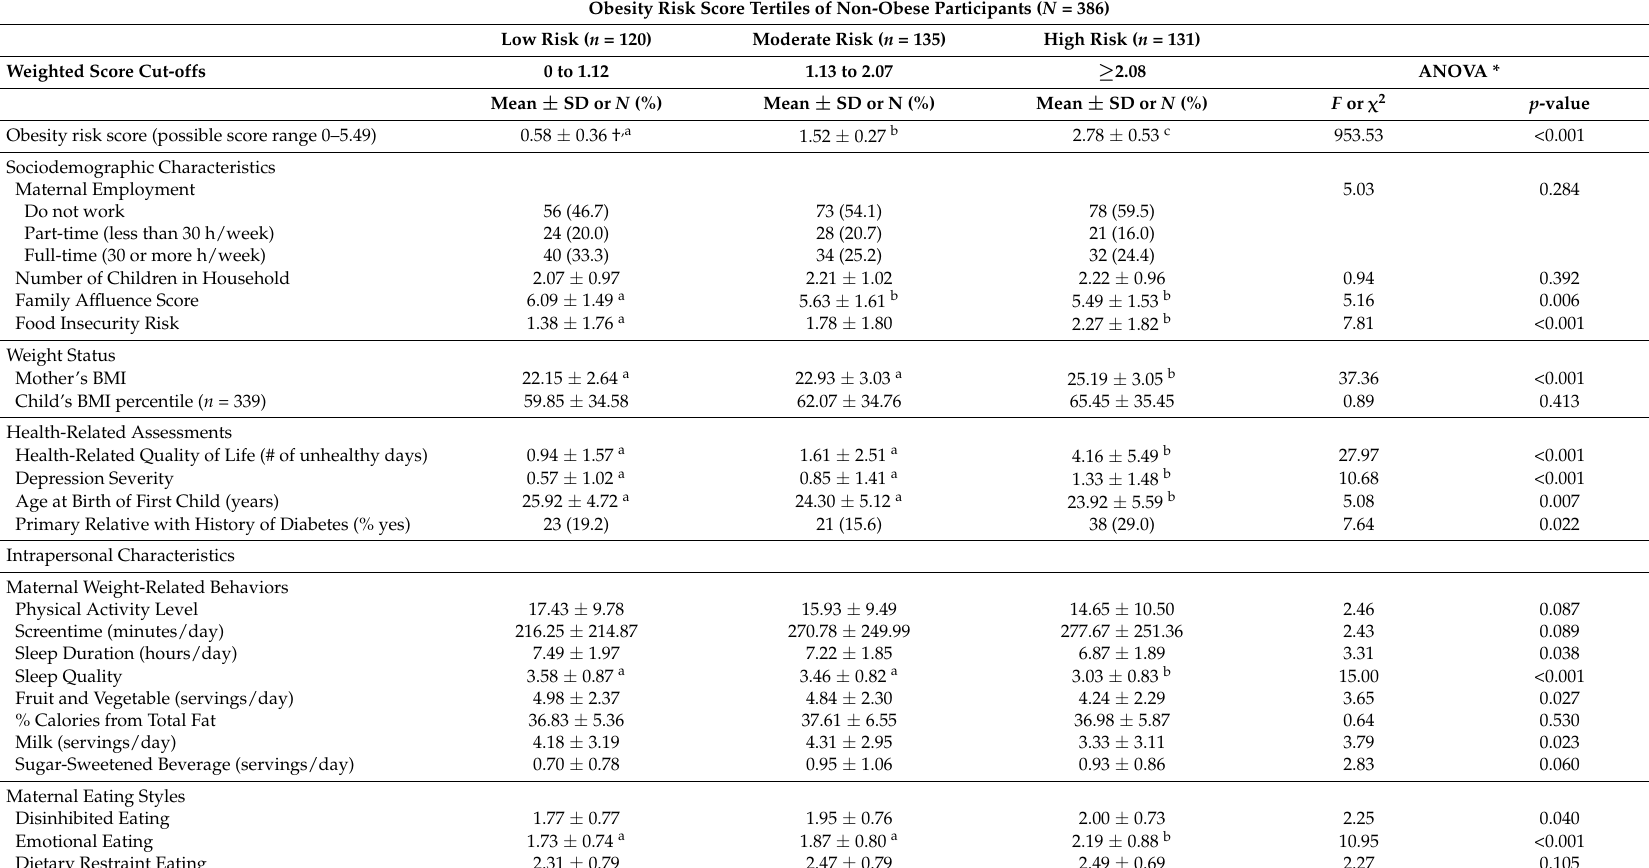
ANOVA of Sociodemographic, Intrapersonal, Interpersonal and Home Environment Characteristics among Obesity Risk Score Tertiles of Non-Obese